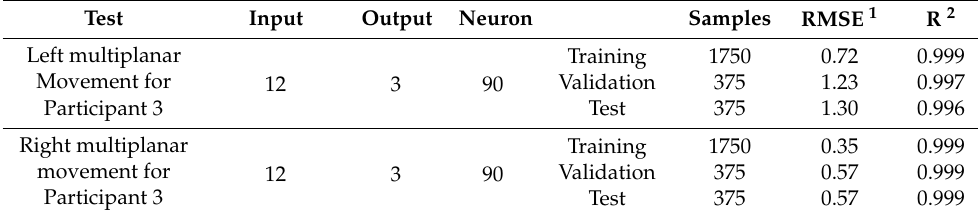
Table 4. The results of the accuracy for TMS by all movements including planar and multiplanar movements as performed by each participant. The outcome of network training for planar movements .